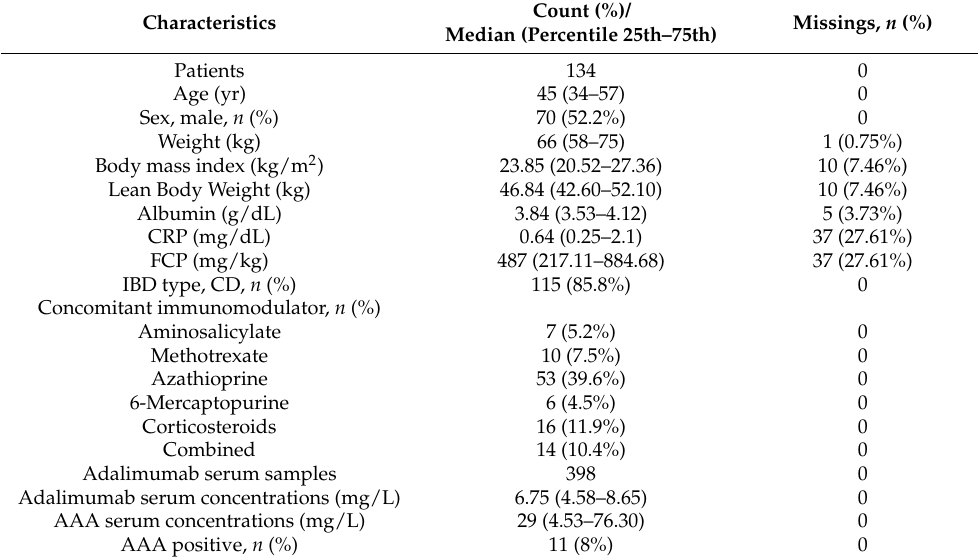
Table 3. Summary of characteristics of included patients.